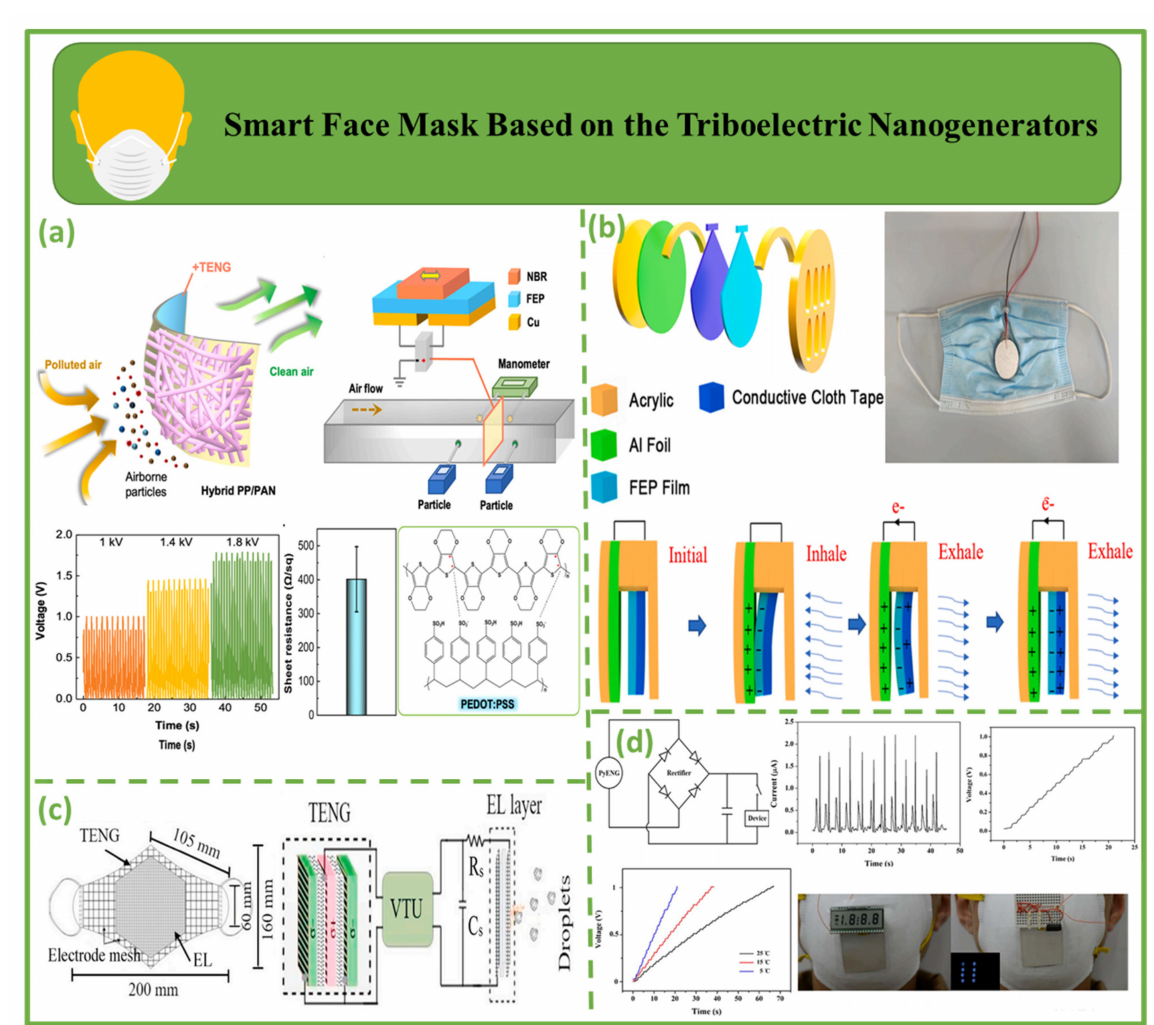
Figure 10. Smart face mask based on triboelectric nanogenerators. ( a ) The filtering principle of a tribocharge air filter face masks [122]. ( b ) Basic design of RS-TENG [123]. ( c ) Representation of the potential functionality of a triboelectric self-powered mask [124]. ( d ) Output efficiency produced by the PyNG when powered by human breathing